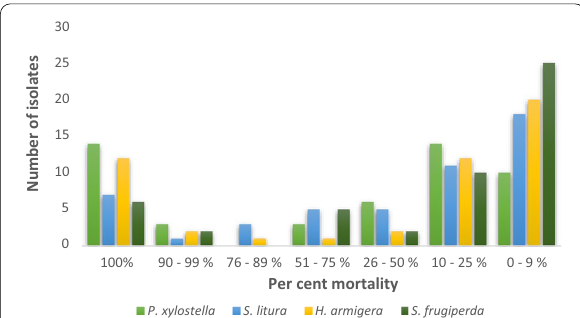
Fig. 4 Variation in mortality of lepidopteran larva with 20 µg/ml of spore crystal mixtures of indigenous Bt isolates